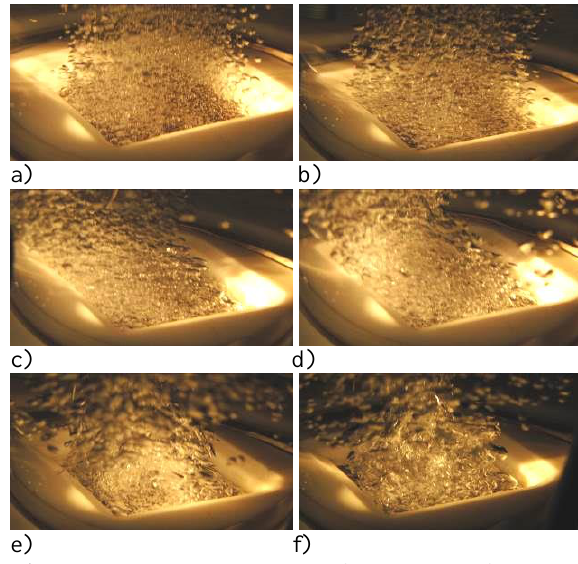
Fig. 9. Averaged departing bubble frequencies for a) Novec- 649, b)